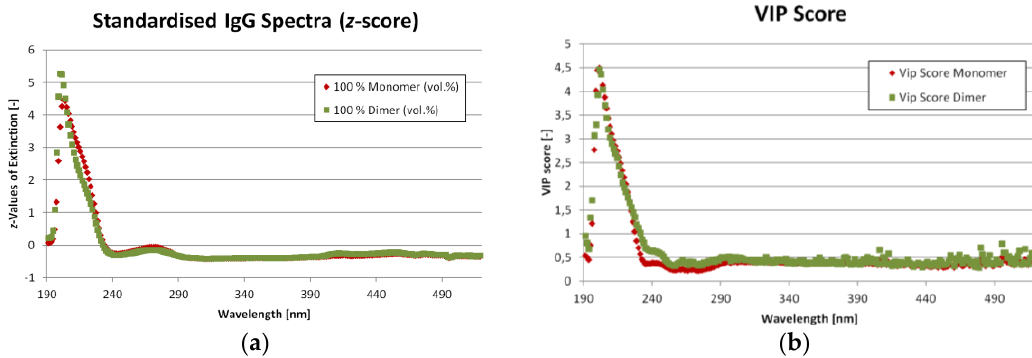
Figure 5. ( a ) Ultraviolet/Visible light (UV/VIS) spectra of the trainings data with the highest and lowest Immunoglobulin G (IgG) monomer content. The red dots represent the mixture with 100 vol.% monomer, the green dots with 100 vol.% dimer, respectively. However, this does not mean pure monomer or dimer since a conversion from one into the other takes place; ( b ) Variable Importance on Projections (VIP) scores for monomer (red) and dimer (green).